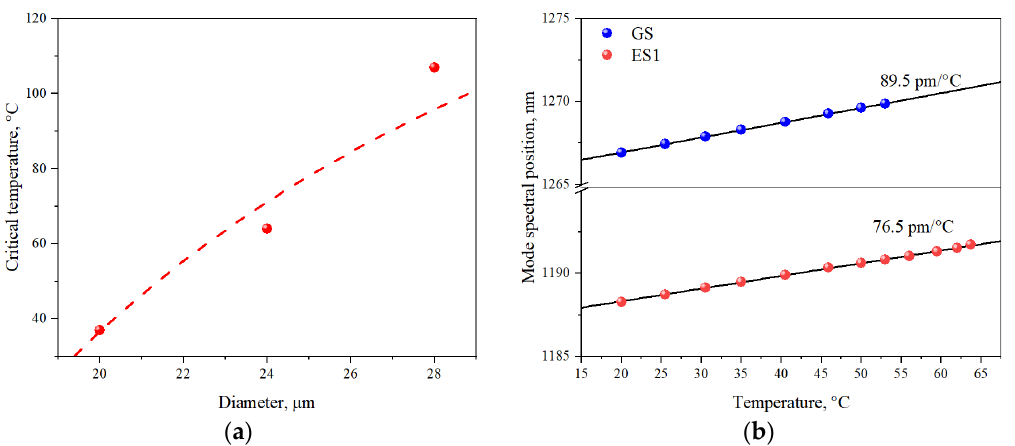
Figure 3. ( a ) Critical temperature of GS lasing against microdisk diameter: experiment (symbols) and simulation (dashed line); ( b ) Dependence of the dominant lasing mode spectral position on the temperature, obtained close to the lasing threshold for the GS and ES1 lasing. Solid lines correspond to the linear dependences.